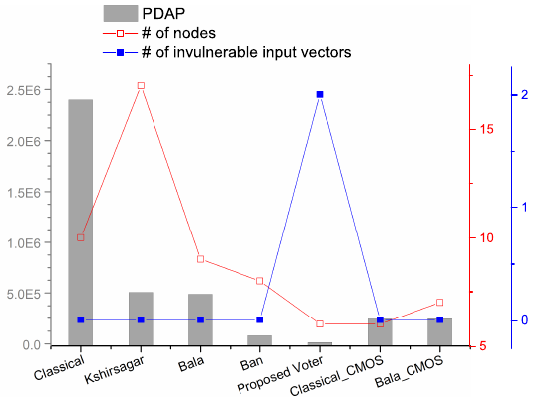
Figure 6. Relationship between nodes, invulnerable vectors, and PDAP.